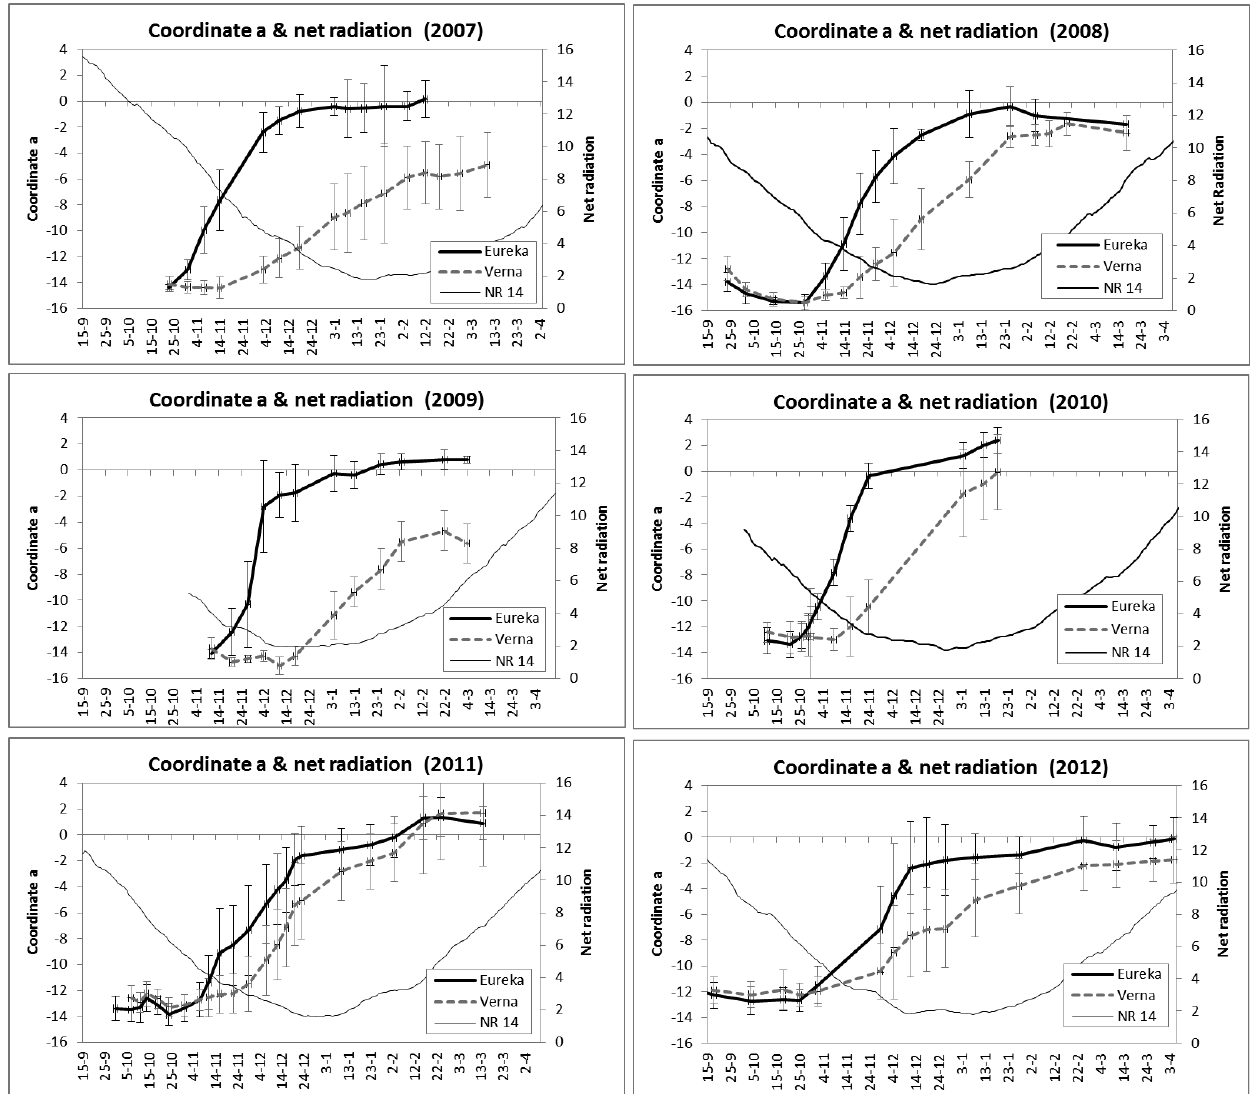
Fig. 4: Evolution of coordinate a and net radiation (mean of 14 days preceding the measurement, and standard deviation) for seasons 2007 to